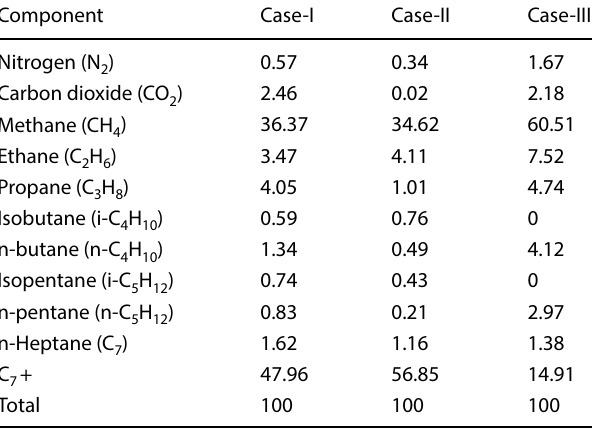
Table 1 Feed Composition of the oil from the